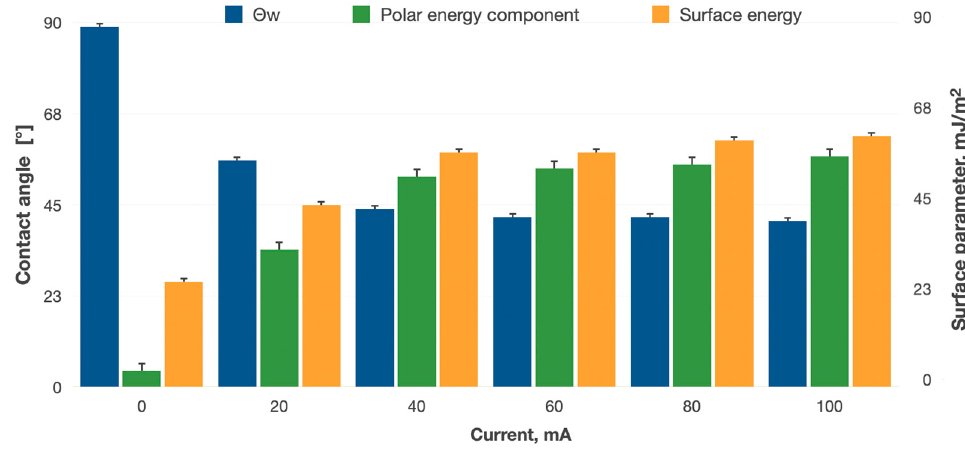
Figure 3. The histograms of the 15-s modified LDPE-substrates’ wetting contact angle (blue), polar component (green), and total value (orange) of the free surface energy dependence on the discharge current values.